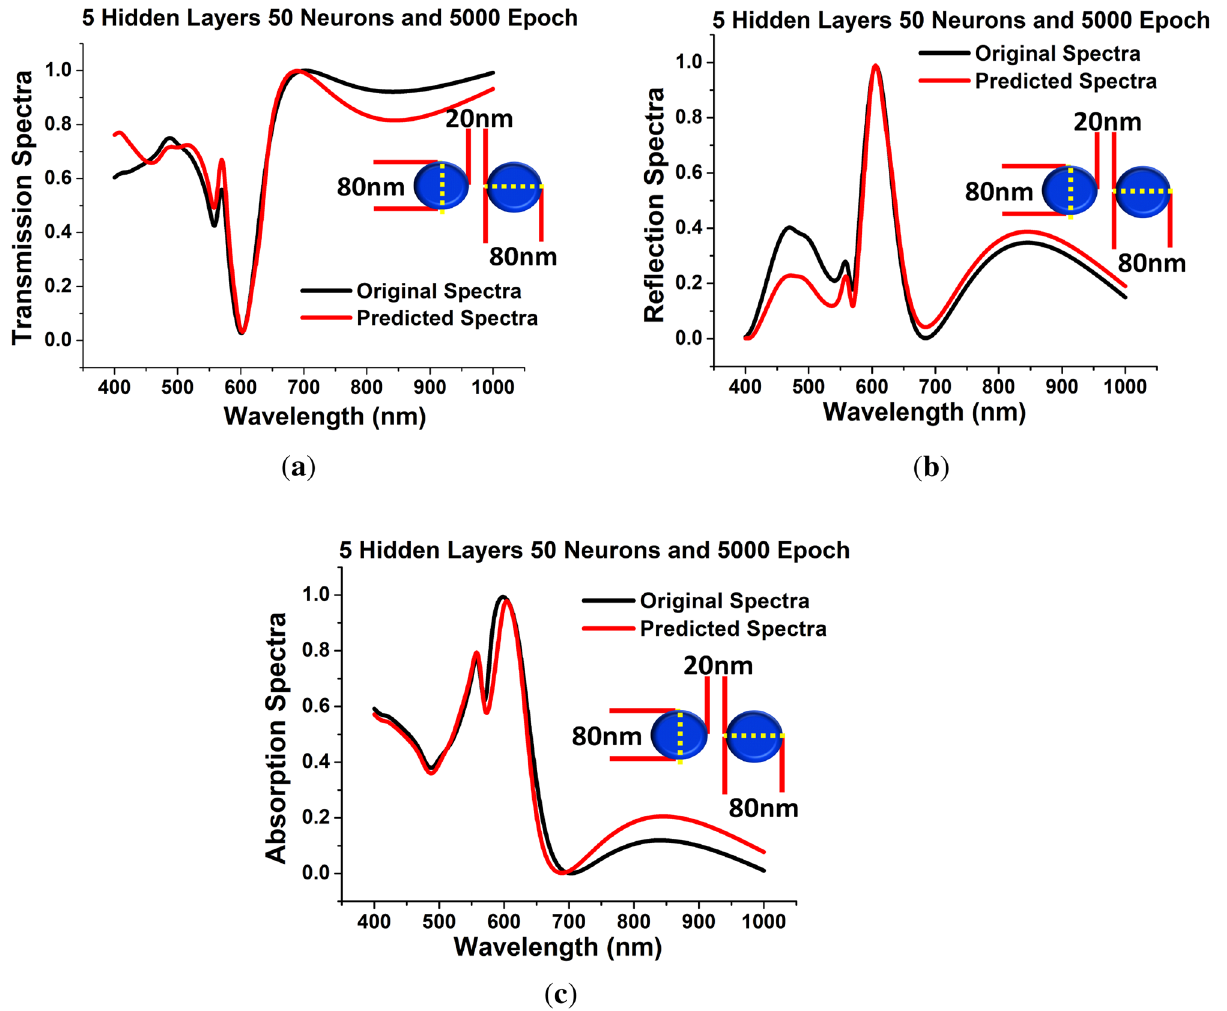
Figure 9. Hidden layer = 5, Neurons = 50 and Epoch = 5000 ( a ) Shows the comparison between the predicted transmission spectra with respect to the original transmission spectra of circular dimer with d = 80 nm, g = 20 nm and h = 40 nm. ( b ) Shows the anticipated reflection spectra are compared to the original reflection spectra. ( c ) Shows the predicted absorption spectra against the original absorption spectra of the